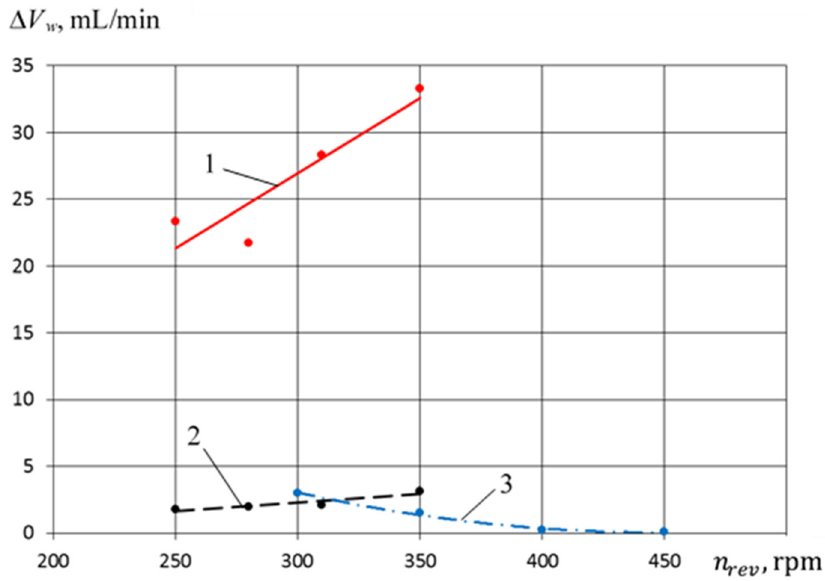
Figure 35. Dependence Δ V w from the angular velocity of the crankshaft (1—PHPM with step-type gap seals; 2—PHPM with smooth gap seals; 3—Crosshead-free PHPM).